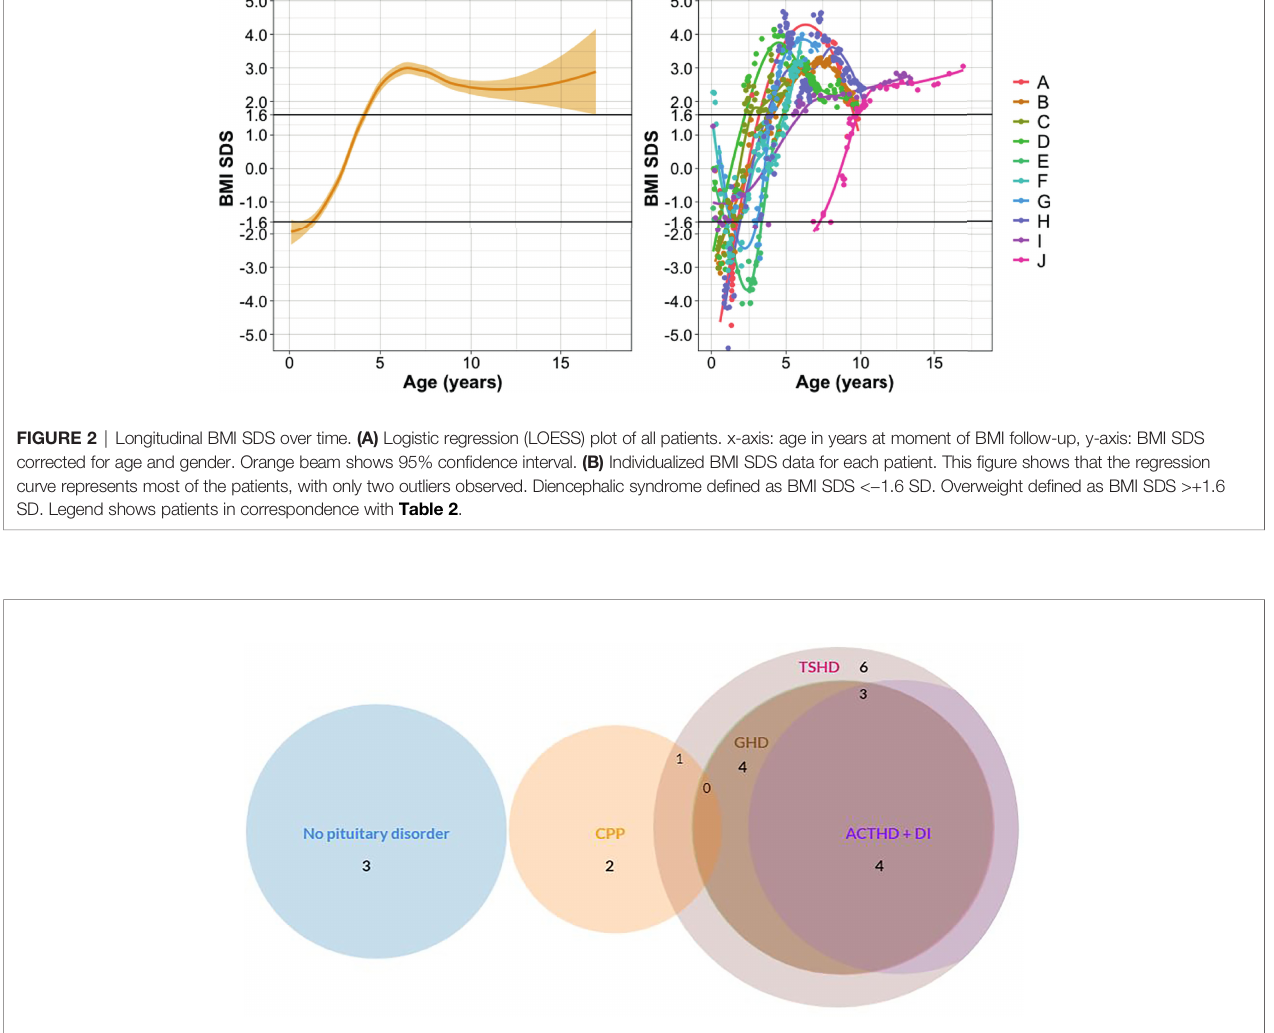
FIGURE 3 | Prevalence of pituitary disorders (anterior pituitary de fi ciency, CPP, DI). ACTHD, adrenocorticotropic hormone de fi ciency; CPP, central precocious puberty; DI, diabetes insipidus; GHD, growth hormone de fi ciency; TSHD, thyroid-stimulating hormone de fi ciency. The circles of ACTHD and DI are completely overlapping: every child with ACTHD also had DI. None of the children had LH/FSHD. N = 3 had no pituitary disorder. N = 1 had CPP. N = 1 had CPP and TSHD. N = 1 had GHD and TSHD. N = 1 had TSHD, ACTHD and DI. N = 3 children had GHD, TSHD, ACTHD, and DI.